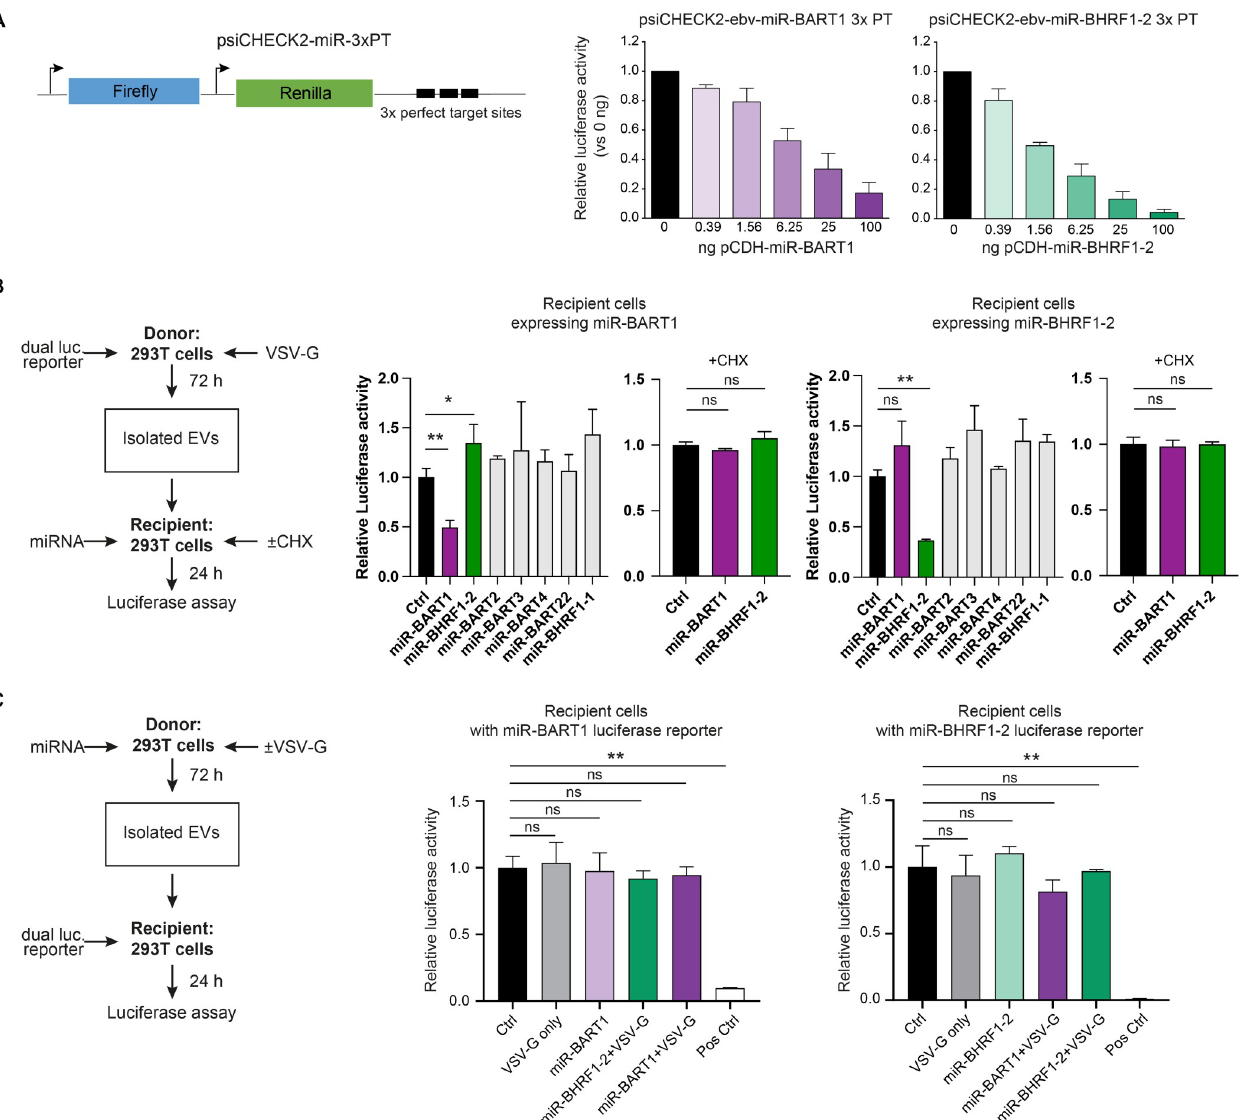
Fig 6. Dual luciferase reporter assays indicate a functional EV-mediated transfer of mRNA transcripts but fail to detect miRNAs-dependent regulation of reporter transcripts in recipient cells. (A) The design of the modified dual luciferase reporter plasmid, based on psiCHECK2, is shown, which encompasses the internal control firefly luciferase (used for normalization) and the reporter Renilla luciferase with three tandem copies of perfect complementary target sites (3xPT) of the miRNAs of interest inserted in the 3 0 UTR of the Renilla mRNA. 293T cells were transfected with 30 ng of the miRNA reporter plasmid containing 3xPT with increasing amounts of the corresponding miRNA expression vector (pCDH) starting with 390 pg up to 100 ng. At 24 h after transfection cells were lysed to determine the Renilla and firefly luciferase activities. Mean of three replicates is shown. (B) Reciprocal dual luciferase assays with EVs engineered to transfer luciferase-encoding mRNAs to recipient 293T cells expressing viral miRNAs. Left panel: overview of the principal components of the dual luciferase assay. 293T donor cells seeded in a 13-cm dish were transiently transfected with 12 μ g of 3x PT psiCHECK2 dual luciferase reporter plasmid DNAs (shown in panel A) together with 8 μ g of a VSV-G expression plasmid. 50 μ l of purified EVs (3.1x10 4 particles/cell) were transferred to recipient 293T cells in 24-well plates transiently transfected with 500 ng expression plasmid DNA encoding miR-BHRF1-2 or miR-BART1 as indicated. As control, recipient 293T cells were also transfected with 500 ng of expression plasmid DNAs encoding miR-BART2, miR-BART3, miR-BART4, miR-BART22 or miR-BHRF1-1. As another control, the recipient cells were incubated with cycloheximide (CHX; 20 μ g/ml) to abrogate translation. Middle and right panels: results of reporter assays lysates from recipient 293T cells expressing miR-BHRF1-2 or miR-BART1 as indicated. The transduced mRNAs encoding Renilla luciferase with the perfect complementary target sites (3xPT) for miR-BHRF1-2 or miR-BART1 (and firefly luciferase used for normalization) are translated and expressed in the recipient cells, but repressed in cells that contain the matching miRNA. Mean and SD of three independent donors are shown. Asterisks indicate statistical significance by paired two-tailed t test. ( � P � 0.05; �� P � 0.01; ��� P � 0.001). (C) Dual luciferase assays with reporter constructs (3x PT psiCHECK2) shown in panel A were performed to investigate the functional transfer of EV-borne viral miRNAs to 293T recipient cells. Left panel: overview of the dual luciferase assay. 293T cells seeded in a 13-cm dish were transiently transfected with expression plasmids (12 μ g) coding for miR-BHRF1-2 or miR-BART1 alone or in combination with an expression plasmid coding for VSV-G (8 μ g). Medium was replaced with fresh medium